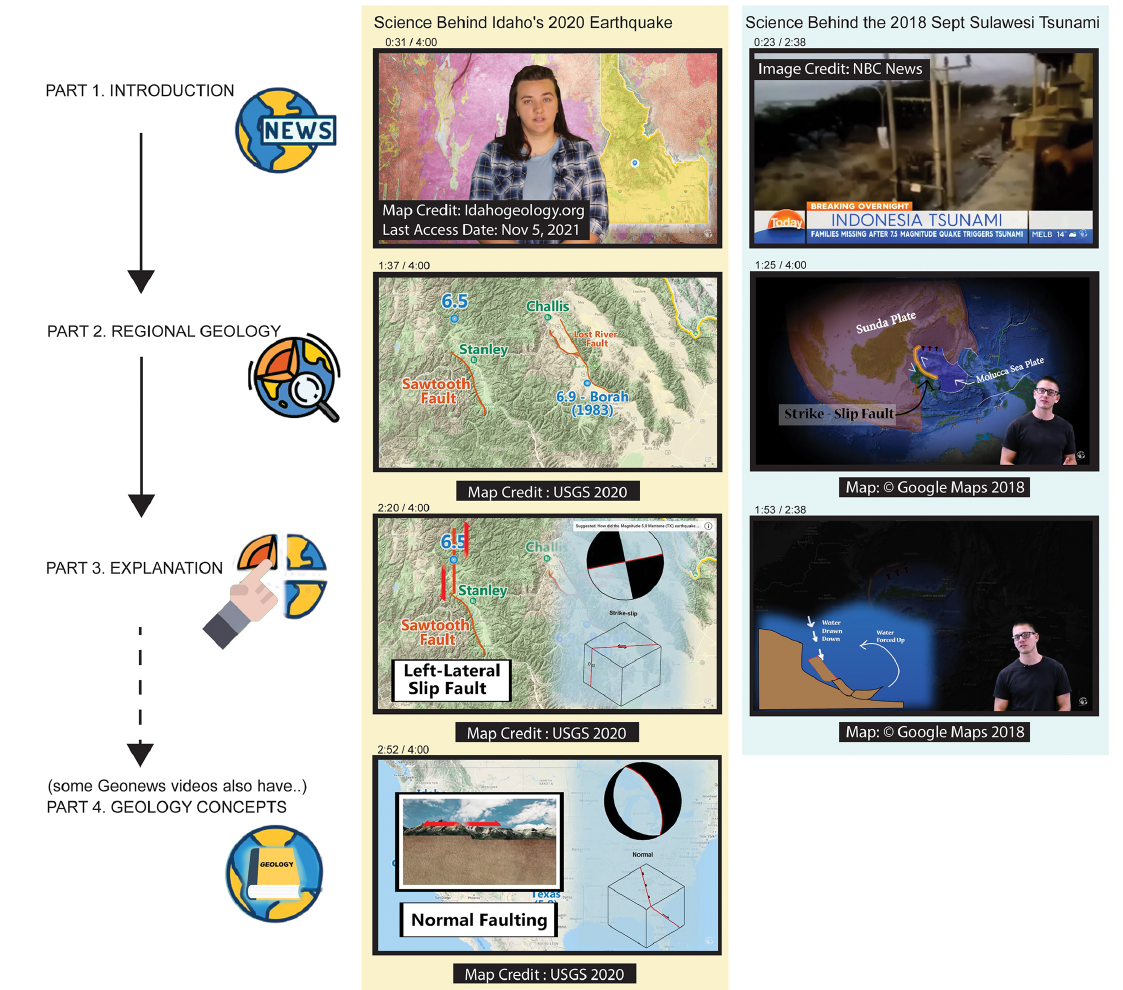
Figure 1. Design framework of Geonews videos and two examples. Details and links for the two Geonews video examples can be found in Table 1 (maps: © Google Maps 2018; U.S. Geological Survey, 2020, https://earthquake.usgs.gov/, last access: 29 April 2022; © Open- StreetMap contributors 2018. Distributed under the Open Data Commons Open Database License (ODbL) v1.0; NBC News Today, 2018; Idaho Geological Survey,